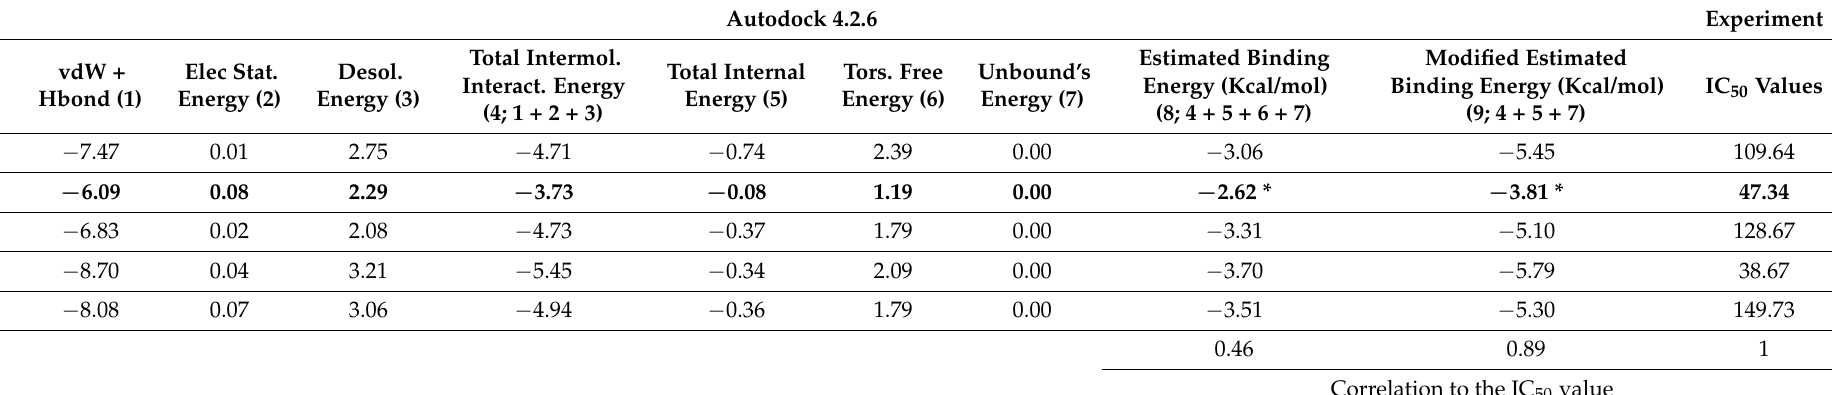
Table 4. Estimated binding energy from a refining docking score through Autodock 4.2.6, including relevance energies, and a correlation with estimated binding energy and IC 50 value from the enzyme binding